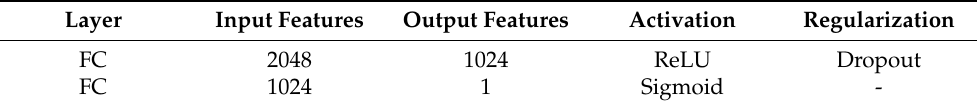
Table A3. The fully connected layers that were added on top of the architecture that is presented in Table A2, for the CNN-based regression and classification. For the regression approach, we used no activation function and the activation function that is highlighted in green is used for the classification approach (not for the FSL approach).